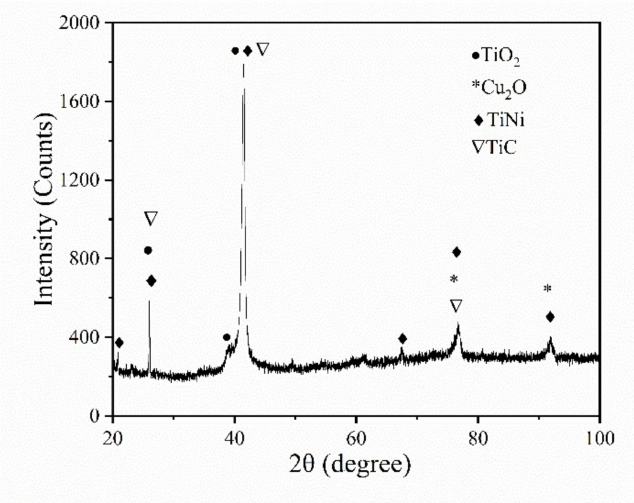
Figure 13. X-ray di ff raction (XRD) pattern of TiNi SMA in 5 g / L